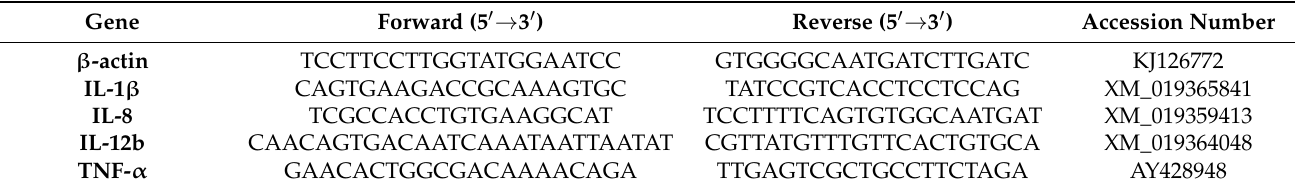
Table 1. Primers used in this